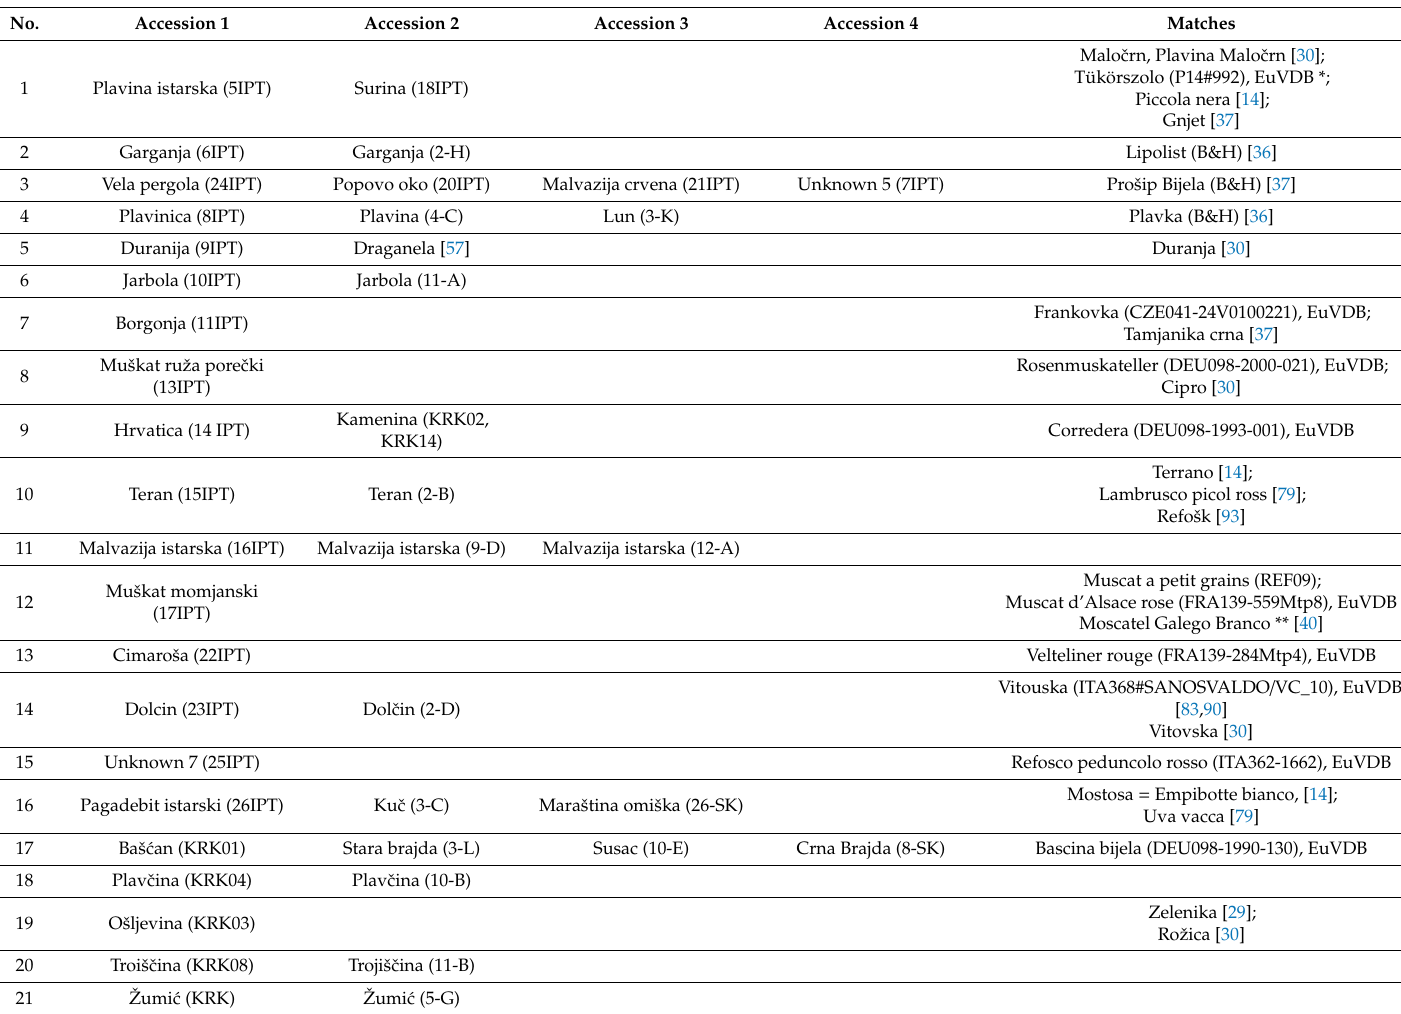
Table 1. List of identified synonyms and duplicates at nine standard simple sequence repeat (SSR)